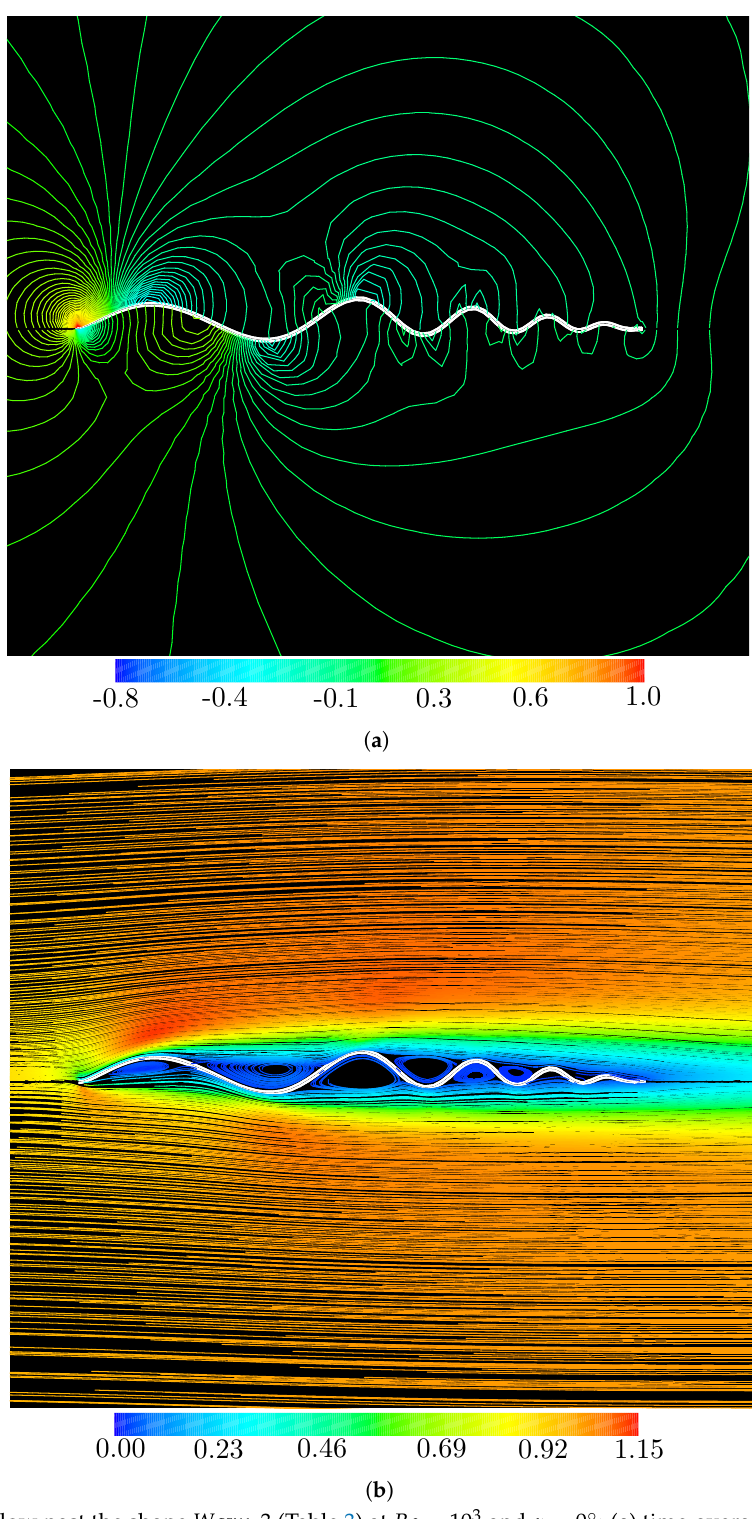
Figure 13. Flow past the shape Wavy _3 (Table 3) at Re = 10 3 and α = 0 ◦ : ( a ) time-averaged pressure isolines; and ( b ) time-averaged